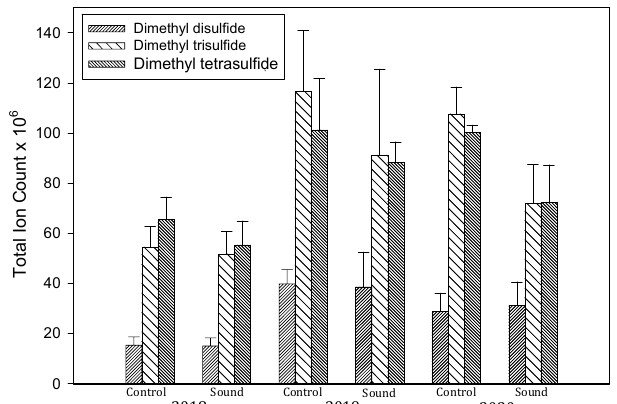
Figure 3. Averaged total ion counts for dimethyl sulfide, dimethyl trisulfide, and dimethyl tetrasulfide in anaerobic digestate, 2018–2020. Data represent the mean ± standard error of the mean.